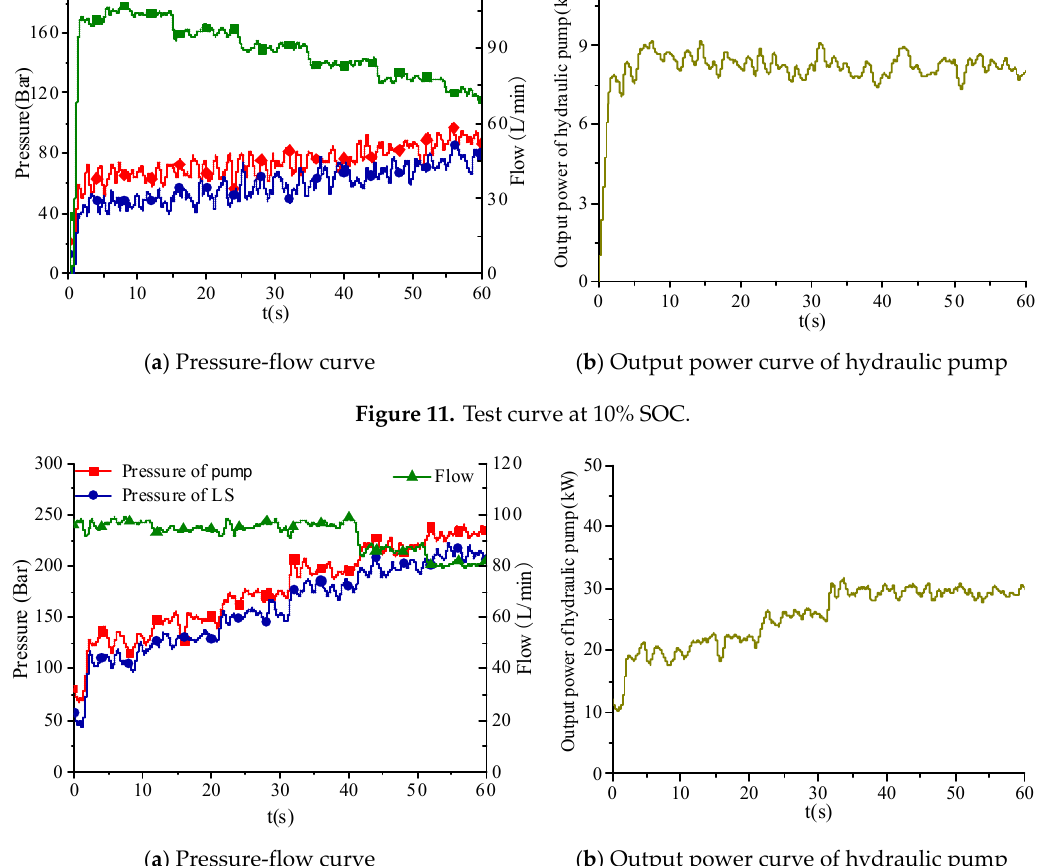
( b ) Output power curve of hydraulic pump Figure 12. Test curve at 30% SOC. Figure 12. Test curve at 30%